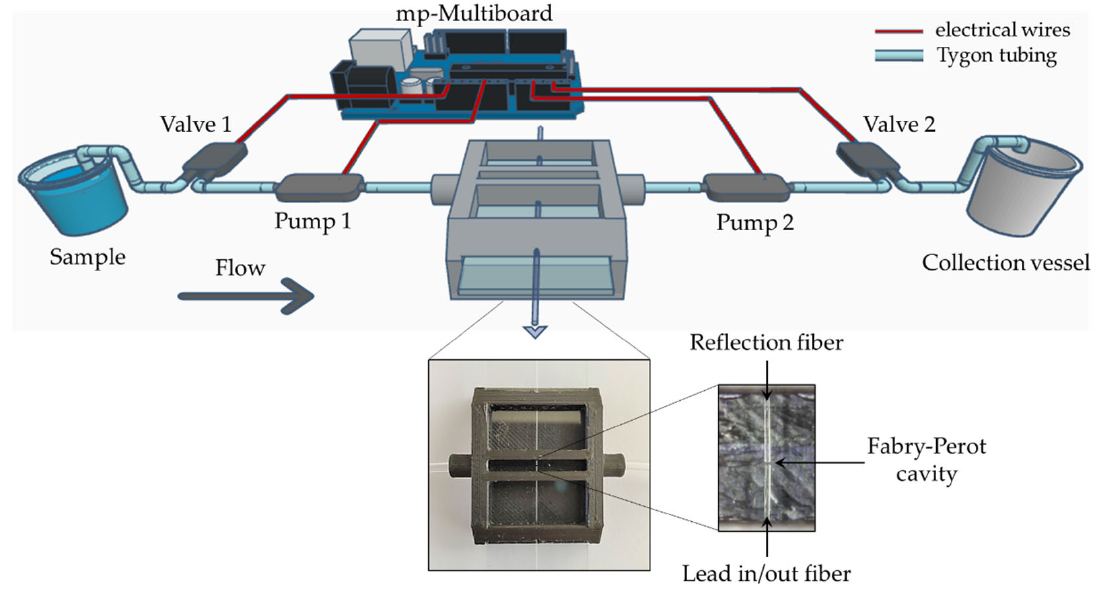
Figure 1. Microfluidic chip design and dimensions.